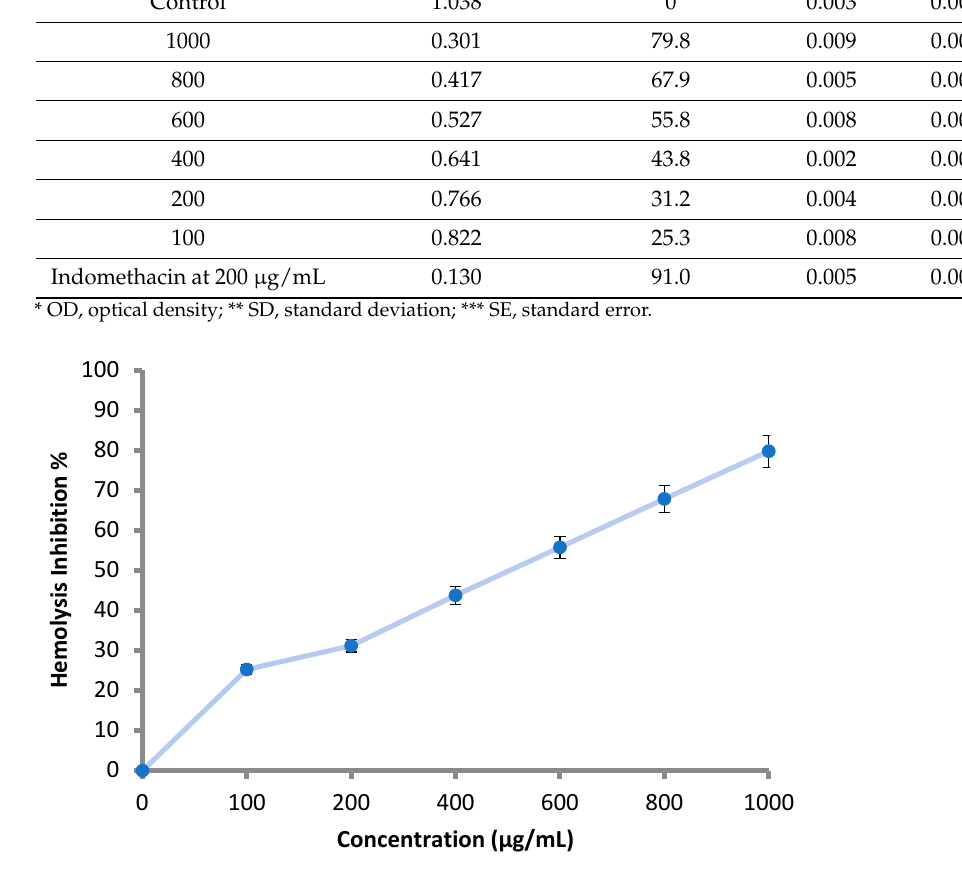
Figure 7. Hemolysis inhibition (%) at different concentration of M. pulegium extract 3.5. Anticoagulant Activity of M. pulegium Extract.